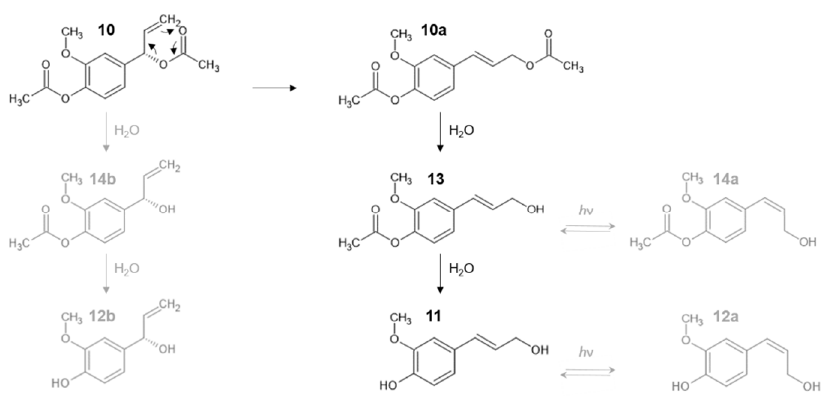
Figure 10. Assumed decomposition of 1′ S -1′-acetoxyeugenol acetate ( 10 ). Compound 10 probably undergoes sigmatropic rearrangement ( 10a ) and subsequent hydrolysis into trans -3-(4-acetoxy-3- methoxyphenyl)-2-propen-1-ol ( 13 ) intermediate, which is transformed by hydrolysis to the trans - p -coniferyl-alcohol ( 11 ) degradation product. The tentative isomer structures in the case of the degradation product 14 are: cis -3-(4-acetoxy-3-methoxyphenyl)-2-propen-1-ol ( 14a ) and (1′ S )-1′-hydroxyeugenol acetate ( 14b ). The putative isomer structures in the case of degradation product 12 are: cis - p -coniferyl-alcohol ( 12a ) and ( S )-4-(1-Hydroxybut-3-enyl)-2-methoxyphenol ( 12b ).